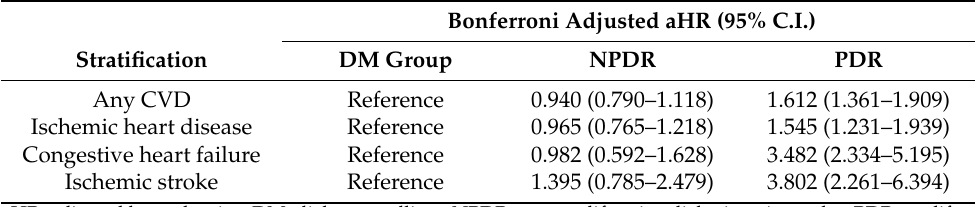
Table 7. Stratified analysis of the disease, NPDR and PDR. Bonferroni Adjusted aHR (95%